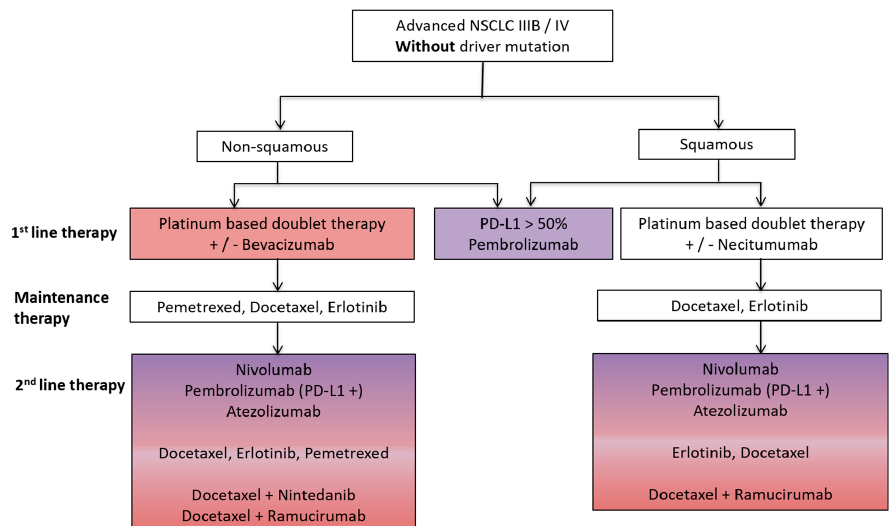
Figure 1. Schematic overview of a standard treatment algorithm in patients with advanced non-small cell lung cancer (NSCLC) IIIB/IV without driver mutation according to the European society of medical oncology (ESMO) guidelines 2016 [1]. Pink: antiangiogenic agent approved as a treatment option; Purple: immunotherapy approved as a treatment option; Pink/Purple: both antiangiogenic agent and immunotherapy approved as a treatment option. PD-L1, programmed death ligand-1.